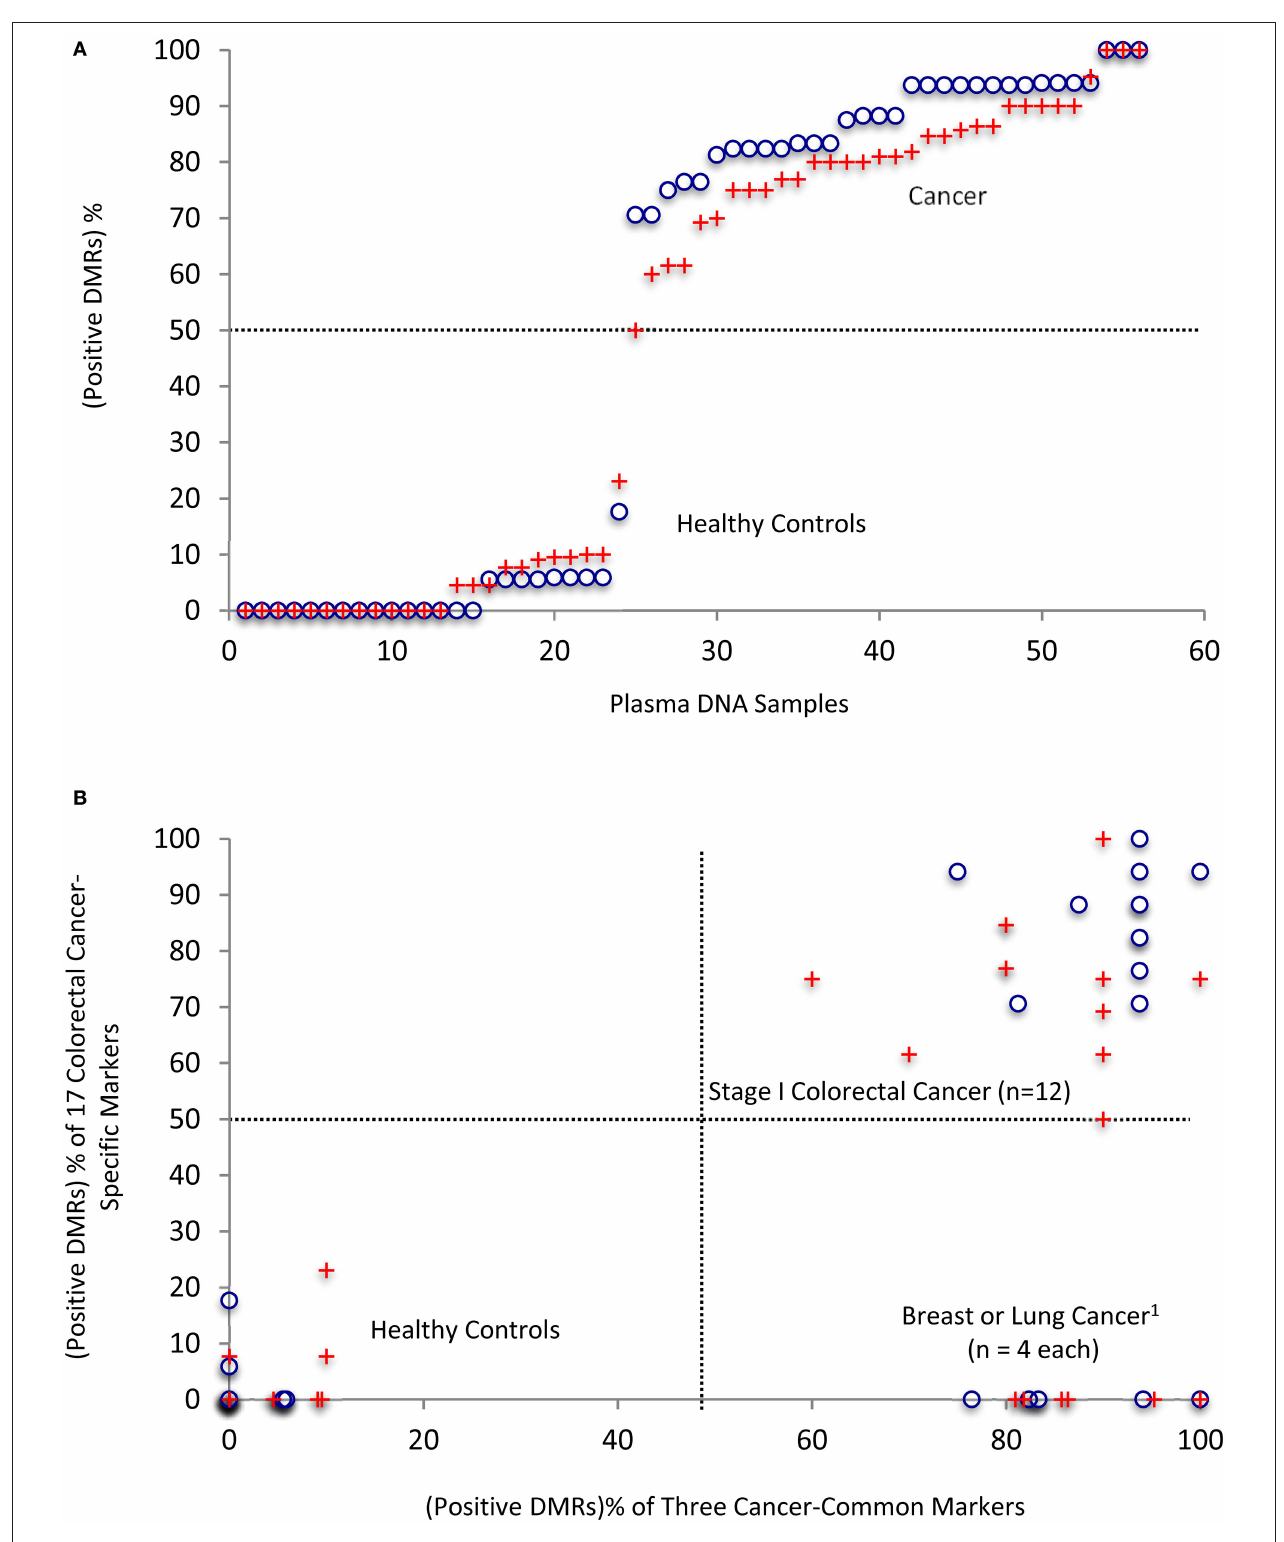
FIGURE 6 | Separation of cancer samples from healthy controls by using the 37 top DMRs in combination. (A) Ranking of all of the individual plasma samples/analyses by the “positive DMR” percentages in each patient or healthy controls. (B) Clean separation of colon cancer (CC) patient samples from